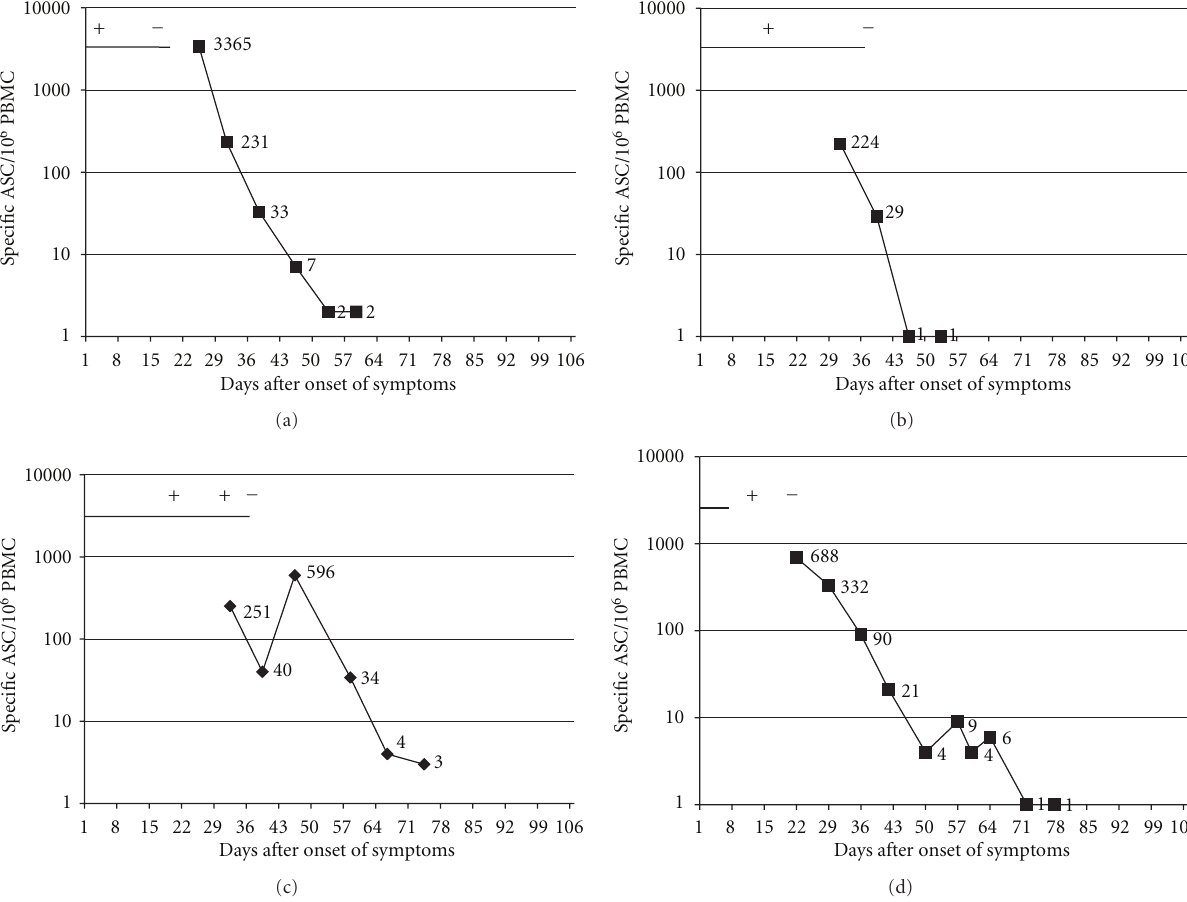
Figure 3: Relation of pathogen-specific circulating plasmablasts (black curve) with symptoms (black horizontal line) and findings in stool samples (+ or − ) in four patients with gastroenteritis caused by Yersinia enterocolitica . The plots represent each data from one individual. The day of the onset of the symptoms was marked as day